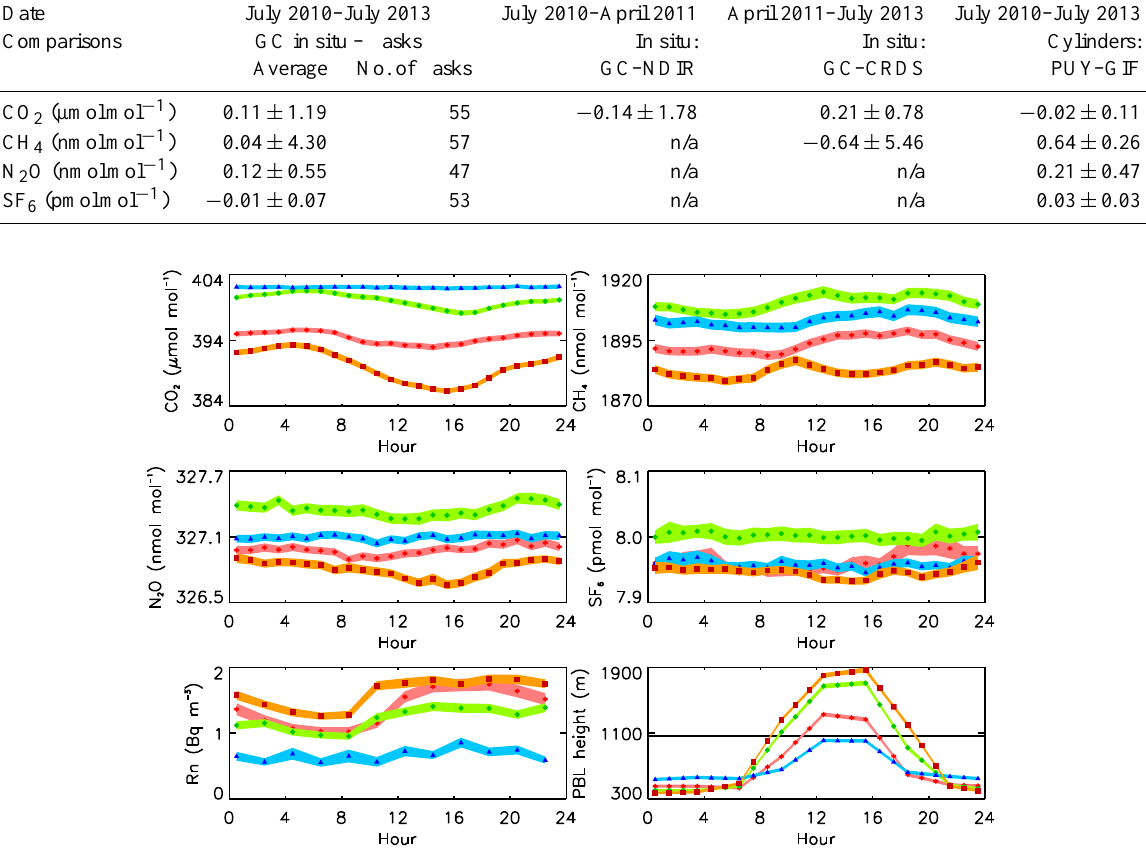
tion is within or above the PBL. The mean diurnal cycles of the PBL height exhibited the same pattern for each sea- son, with an increase in height from 06:00 to 12:00 UTC fol- lowed by a stable height until 15:00 UTC. After 15:00 UTC, the PBL height began to decrease, reaching a minimum af- ter 21:00 UTC. On a mean annual scale, the GC sampled the trace gases within the PBL between 09:00 and 18:00 UTC with an enlarged time step in summer and a narrower time step in winter. In winter, the Puy de Dôme station is often above the PBL during several consecutive